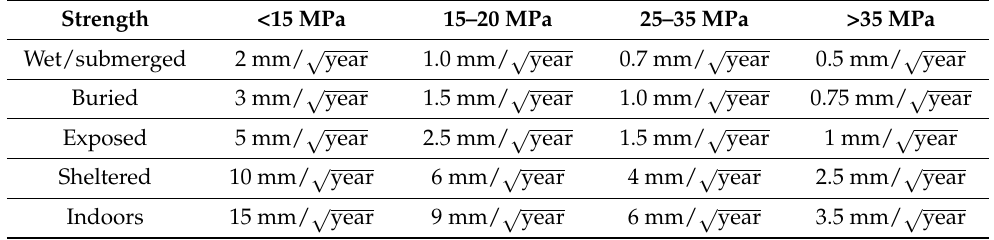
Table 6. Suggested k values for concrete surfaces made from CEM I and